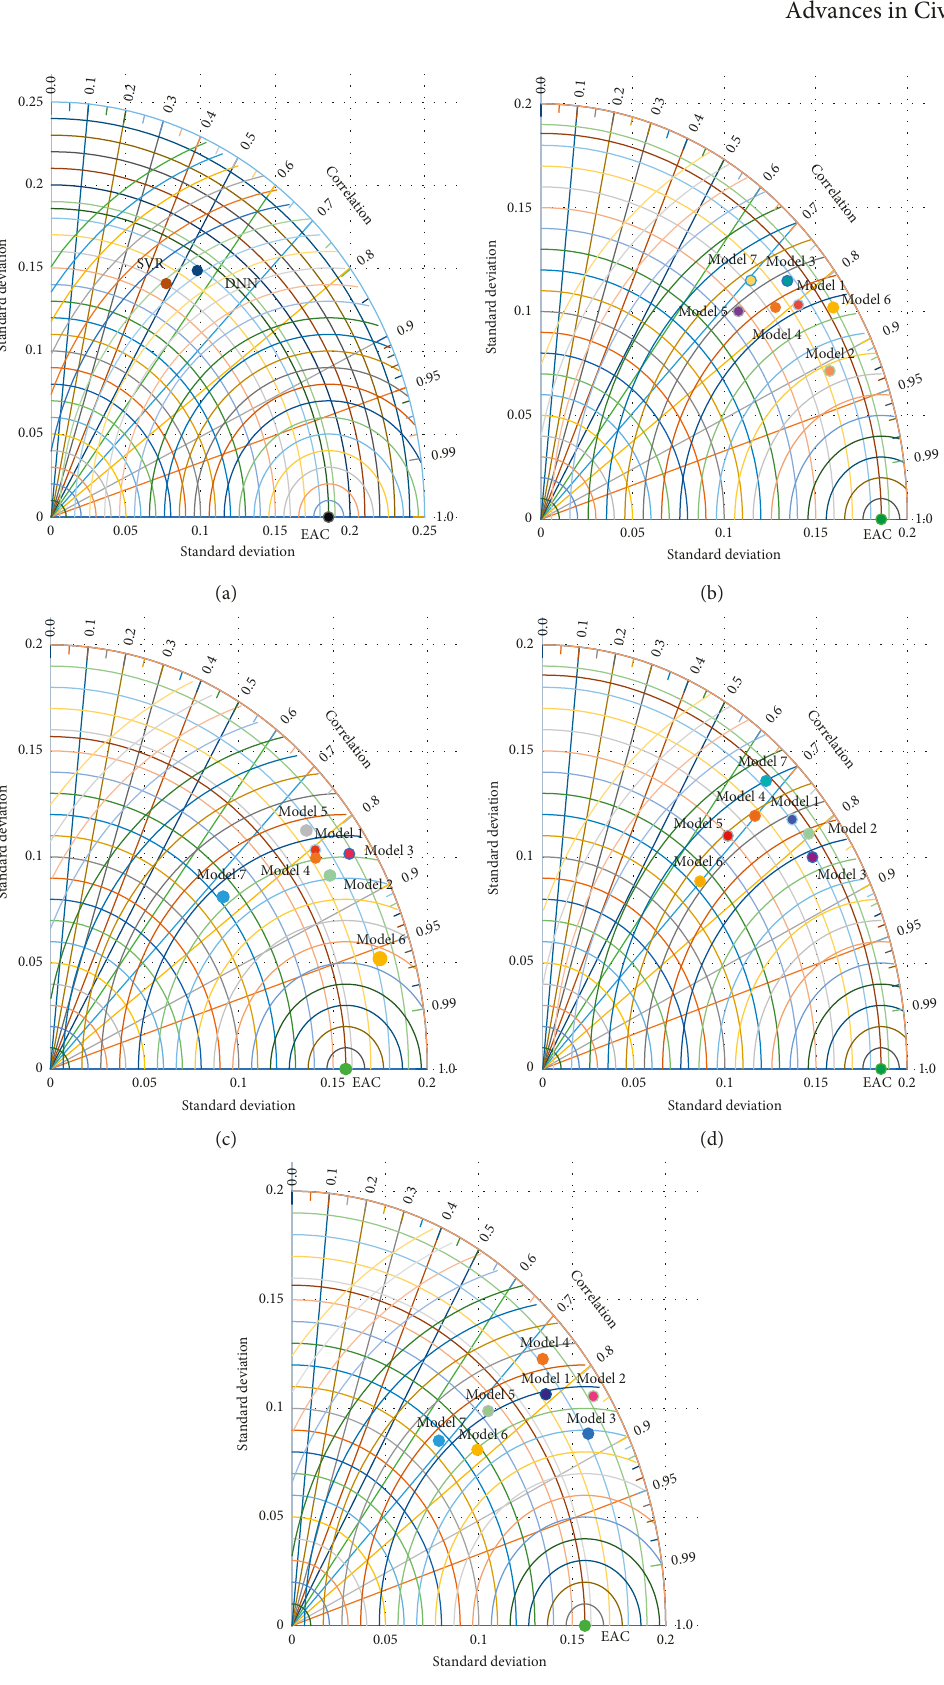
F IGURE 6: Two-dimensional standard deviation and correlation statistic (i.e., Taylor diagram): (a) stand-alone DNN and SVR models; (b) GA-DNN input combinations; (c) GA-SVR input combinations; (d) BF-DNN input combinations; (e) BF-SVR input